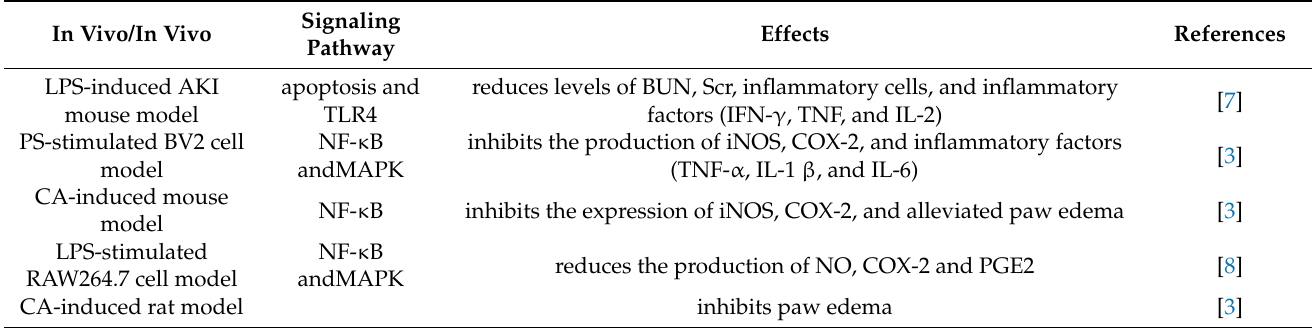
Table 1. Anti-inflammatory activities of